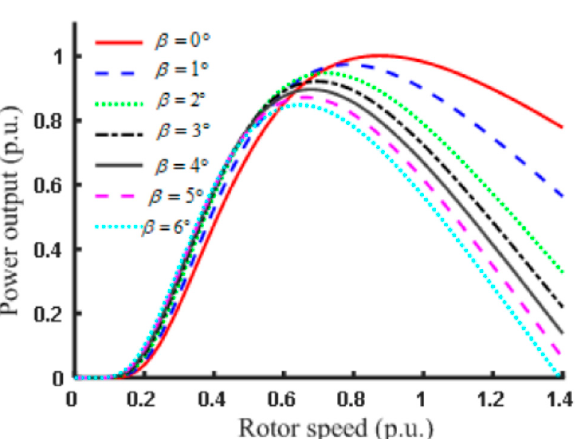
Figure 3. Tidal rotor speed vs. power output at di ff erent blade pitch angles